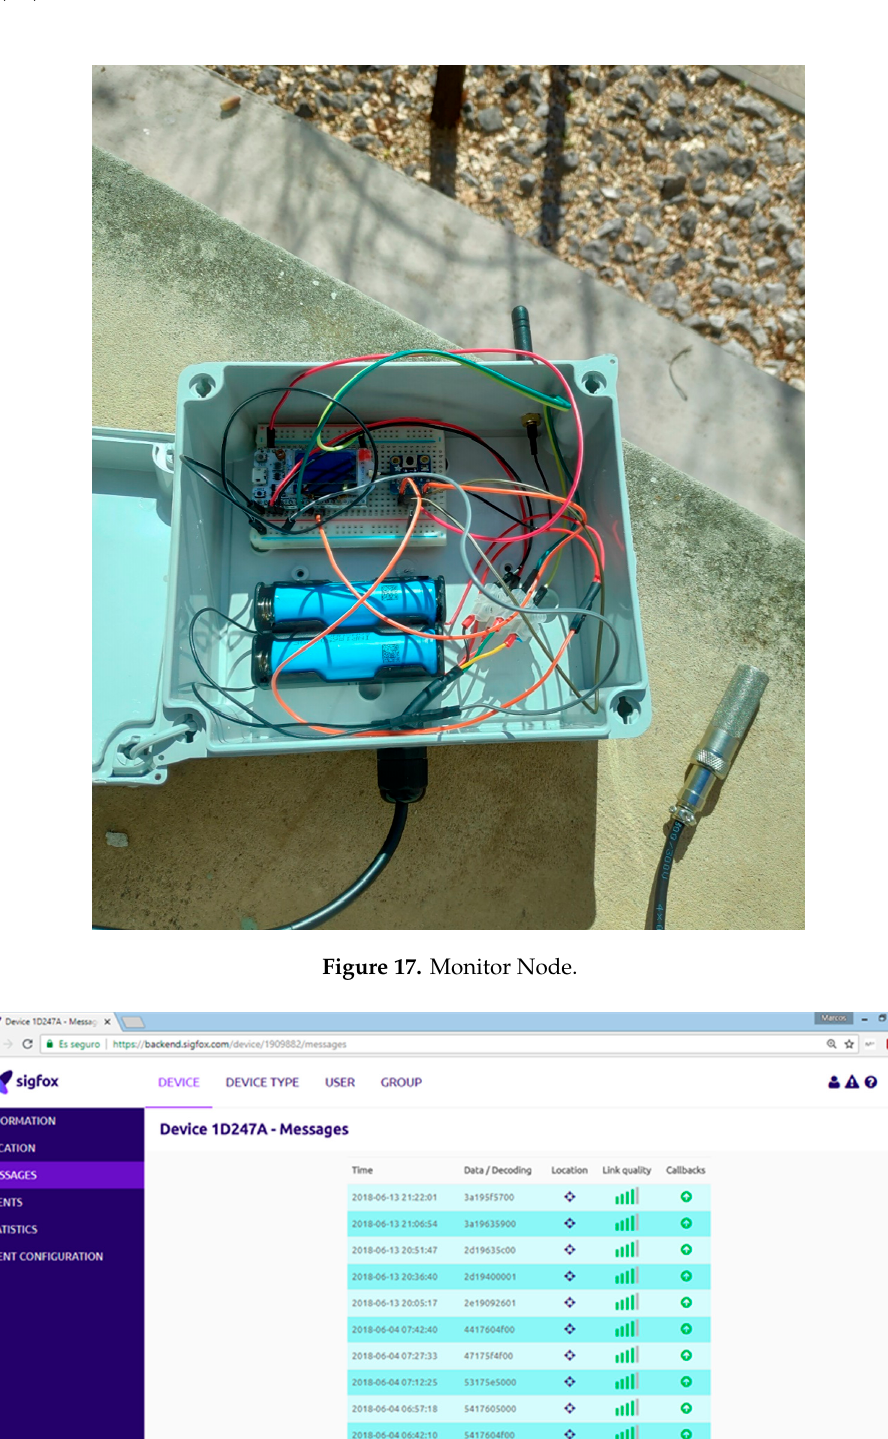
Figure 19. Farm location. In October 2018, monitoring and control systems for three irrigation sectors were installed. Figure 8 also shows the layout of hydrant nodes, monitor and gateway. Figure 9 shows the layout of a monitor node in the field, while Figure 20 shows stored humidity data on the ThingSpeak platform. No transmission faults were detected during the test period.